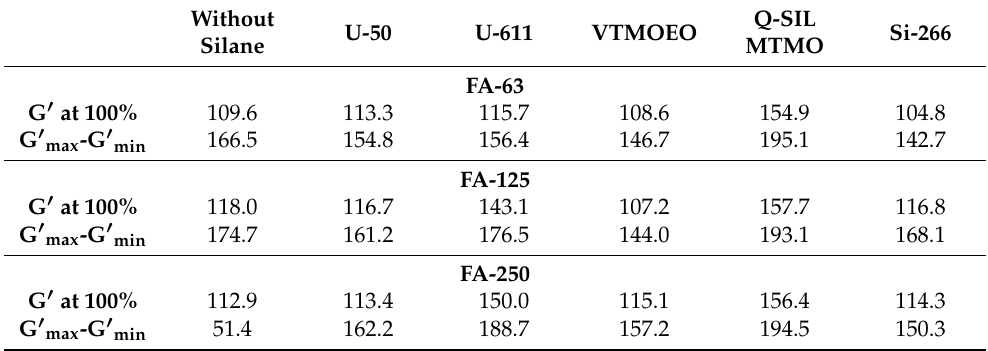
Table 5. Payne effect for the rubber compounds filled with 30 phr of N-220 and 20 phr of unmodified or silanized FA